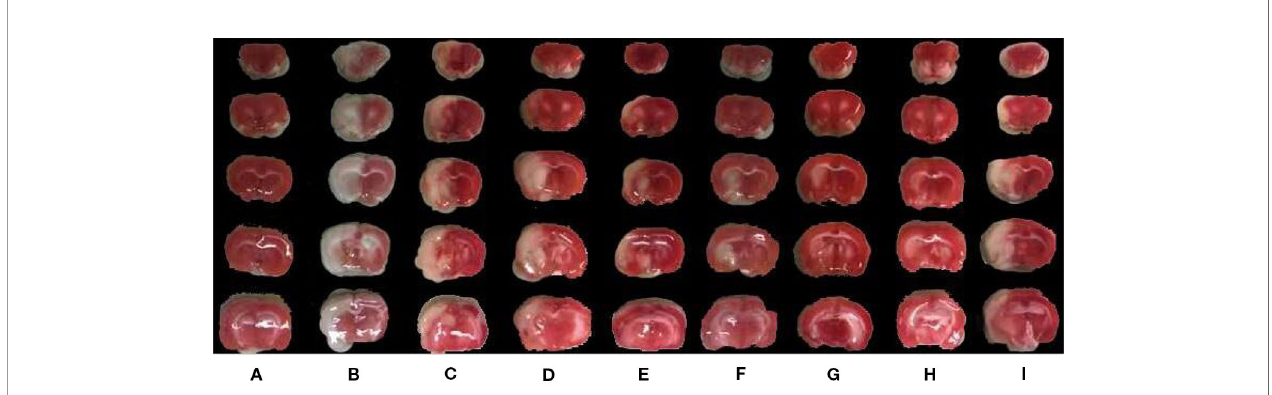
FIGURE 1 | The effects of BZP on infarction volume area of brain in MCAO rats. Note: (A) Sham group; (B) Model group; (C) BZP 0.6 mg/kg group; (D) BZP 1.2 mg/kg group; (E) BZP 2.5 mg/kg group; (F) BZP 5 mg/kg group; (G) BZP 10 mg/kg group; (H) BZP 20 mg/kg group; (I) C8E4 10 mg/kg group. Animals were treated with BZP (0.6, 1.2, 2.5, 5, 10, 20 mg/kg), C8E4 (10 mg/kg) before